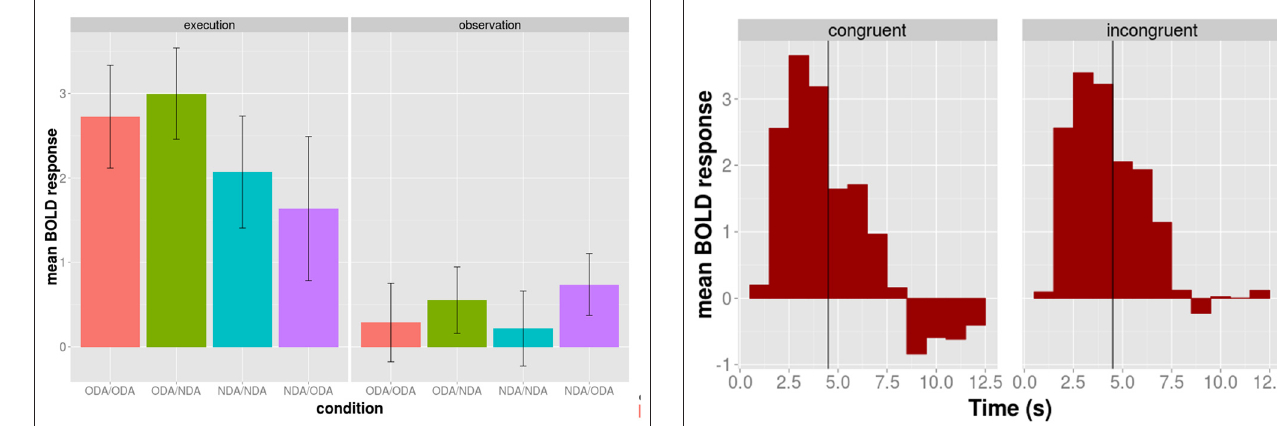
FIGURE 4 | The time course of the average BOLD response of the 52 BA 44/45 voxels shown for congruent (left panel) and incongruent (right panel) conditions separately. The black vertical line indicates the transition between the execution and the observation